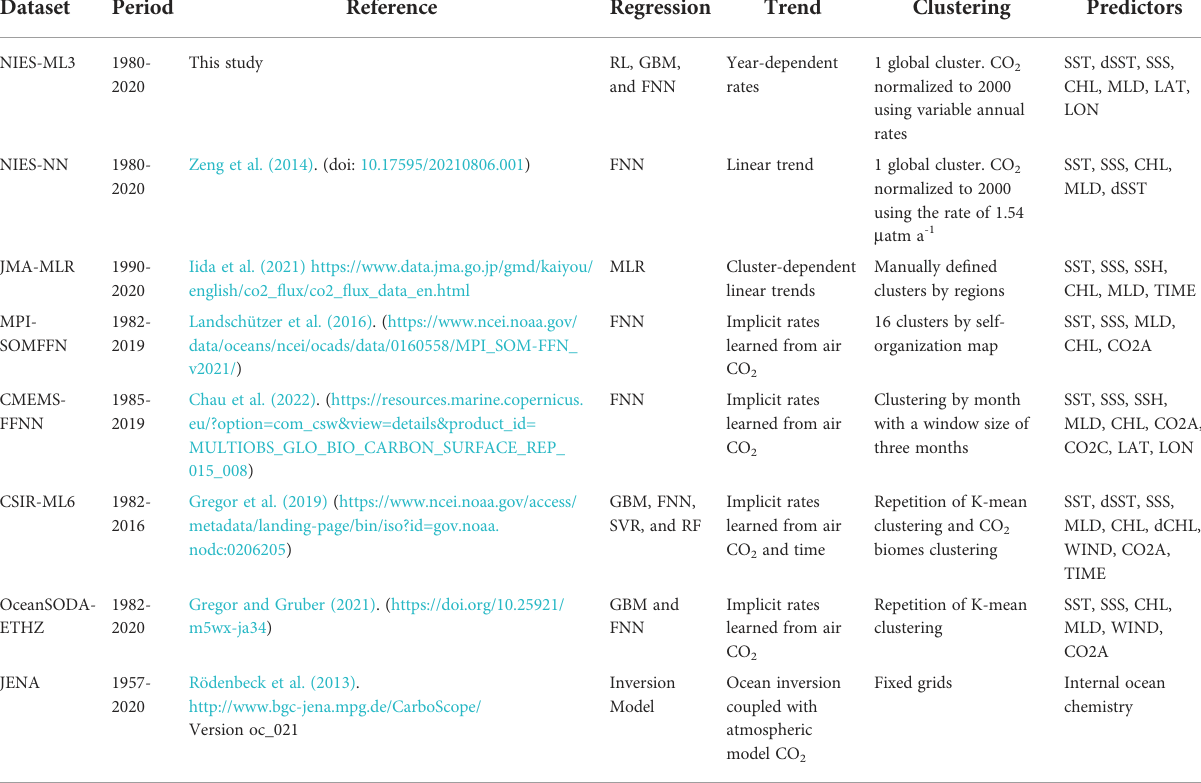
Machinelearningmodelsincluderandomforest(RF),gradientboostmachine(GBM),feedforwardneuralnetwork(FNN),supportvectormachineforregression(SVR),andmultiplelinear regression (MLR). Predictors include atmospheric CO 2 (CO2A), ocean CO 2 climatology (CO2C), sea surface temperature (SST), sea surface temperature anomaly (dSST), sea surface salinity (SSS), sea surface height (SSH), chlorophyll-a (CHL), chlorophyll-a anomaly (dCHL), mixed layer depth (MLD), wind speed (WIND), time (TIME), latitude (LAT), and longitude